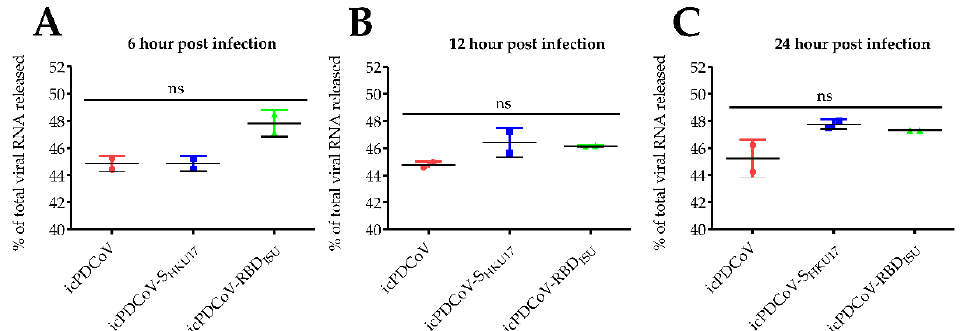
Figure 7. Released ratios of viral RNAs in inoculated DF-1 cells. The DF-1 cells were inoculated with icPDCoV, icPDCoV-S HKU17 , and icPDCoV-RBD ISU viruses at an MOI of 1. Data shown are levels of virus quantified in DF-1 from virus associated with DF-1 compared with the same inoculated DF-1 cells in cell-free fraction at ( A ) 6 hpi, ( B ) 12 hpi, and ( C ) 24 hpi. All data points (cts) were first converted to GE/mL, and then, the percentage of releases was calculated, according to the equation previously described. GE, genomic equivalent. One-way ANOVA with Tukey’s multiple comparisons post hoc test, p ≤ 0.05, ns; not statistically significant.